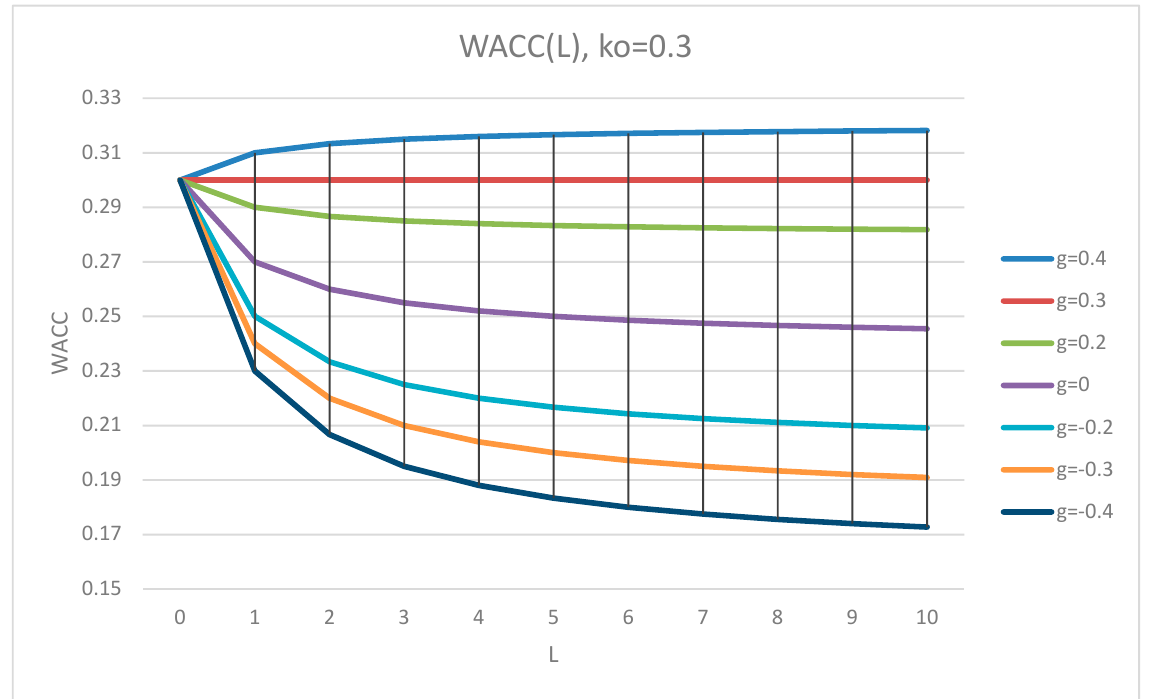
Figure 3. Dependence of WACC on leverage level L in Generalized Modigliani–Miller theory (GMM theory) at k 0 = 0.3 and g = 0; ± 0.2; ± 0.3; ± 0.4.